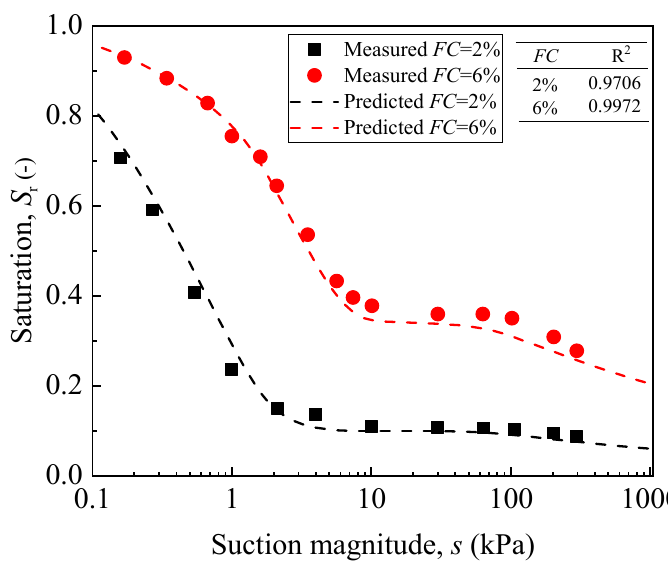
Figure 7. The predicted SWRCs versus the measured data for FC = 2% and 6%.